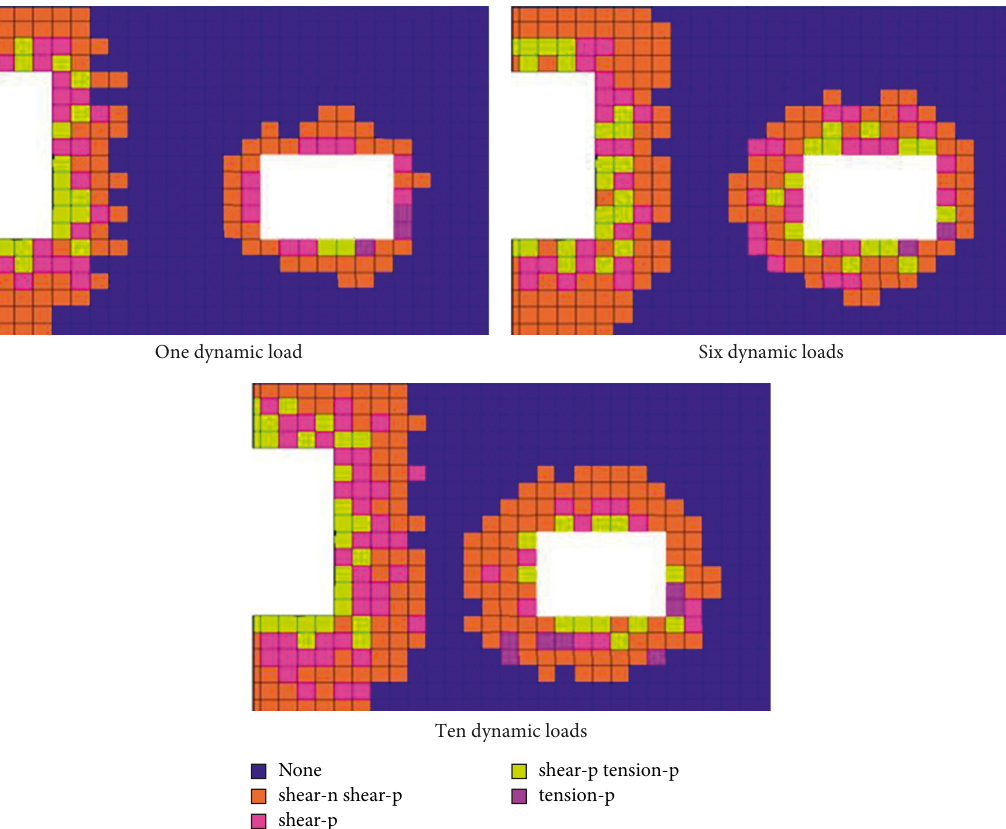
Figure 3: FLAC simulations of the plastic zone after one, six, and ten dynamic